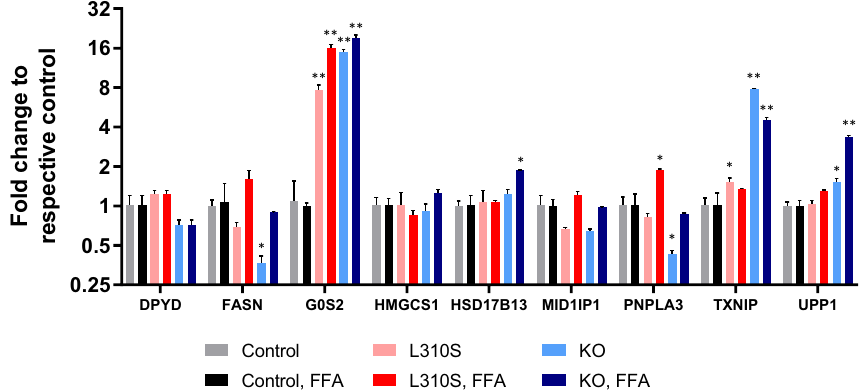
Figure 10. qPCR demonstrates differential gene expression across three DPYD CRISPR-Cas9 engineered cell lines; control (black), L310S (light gray) and KO (dark gray). ( A ) Under basal conditions, in the absence of FFA exposure, DPYD, HMGCS1, HSD17B13, and MID1IP1 expression is consistent across the three cell lines. FASN expression is significantly downregulated in the L310S line relative to control (adjusted p-value 0.0044). G0S2 is significantly upregulated in both the KO and L310S line relative to control (adjusted p-value < 0.0001 for both lines). PNPLA3 expression is significantly decreased in the KO line *adjusted p-value 0.0093). TXNIP expression is significantly increased in the L310S line (adjusted p-value 0.0261) and the KO line relative to control (adjusted p-value < 0.0001). UPP1 expression is significantly increased in the KO line relative to control (adjusted p-value 0.0244). ( B ) Following exposure to FFAs, DPYD, FASN, HMGCS1, and MID1IP1 expression remains consistent across lines. G0S2 expression significantly increased in both the L310S and the KO line relative to control (adjusted p-value < 0.0001). HSD17B13 expression significantly increases in the KO line relative to control (adjusted p-value of 0.0105). PNPLA3 expression significantly increases in the L310S line relative to control (adjusted p-value of 0.0101). TXNIP and UPP1 expression significantly increased in the KO line relative to control (adjusted p-values <